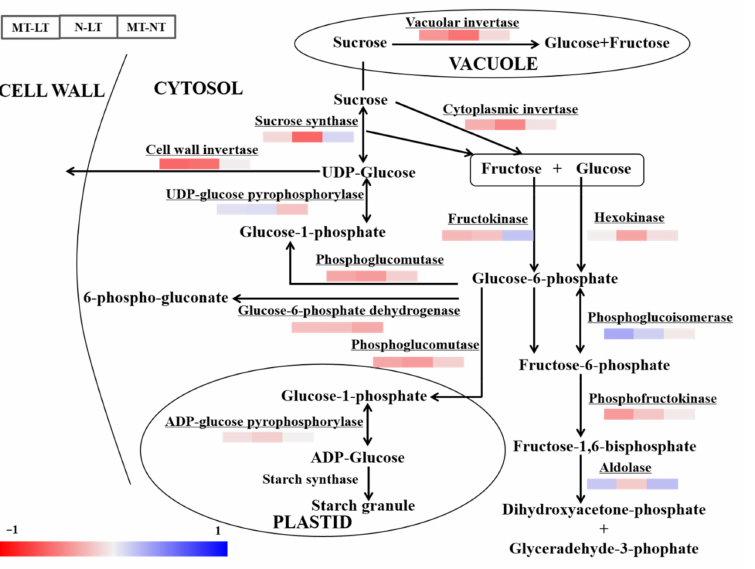
Figure 4. Heatmap of key carbohydrate metabolism enzyme activities in offspring wheat leaf as